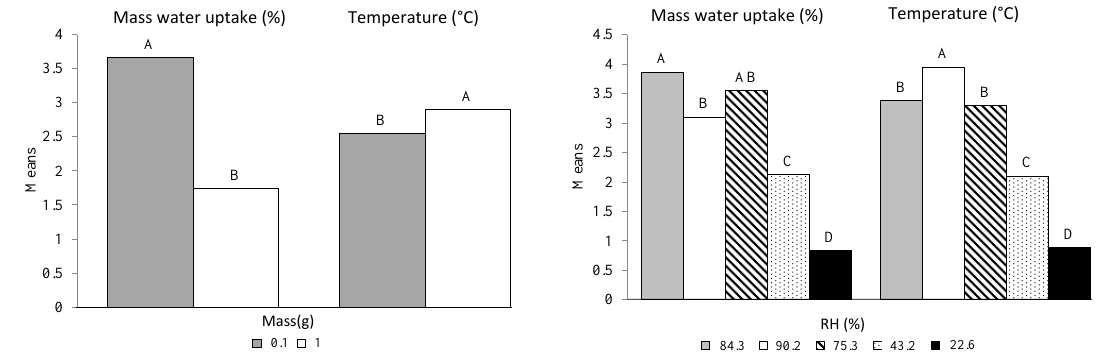
Figure 6. Mass and Relative humidity multiple comparisons according to the Tukey test. The means with the same letter were not significantly different at 5% (α = 0.05).